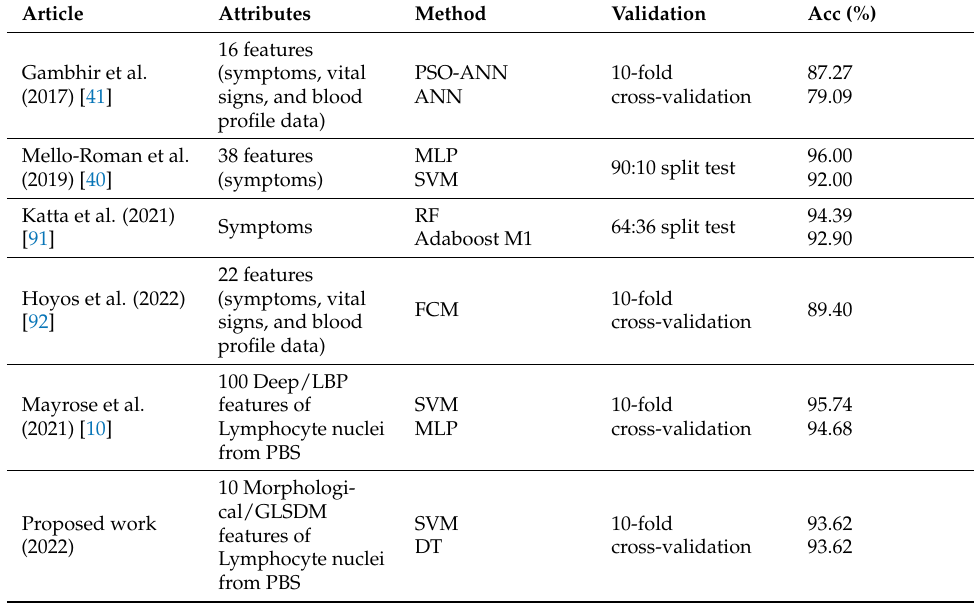
Table 5. Comparative summary of this study with other existing